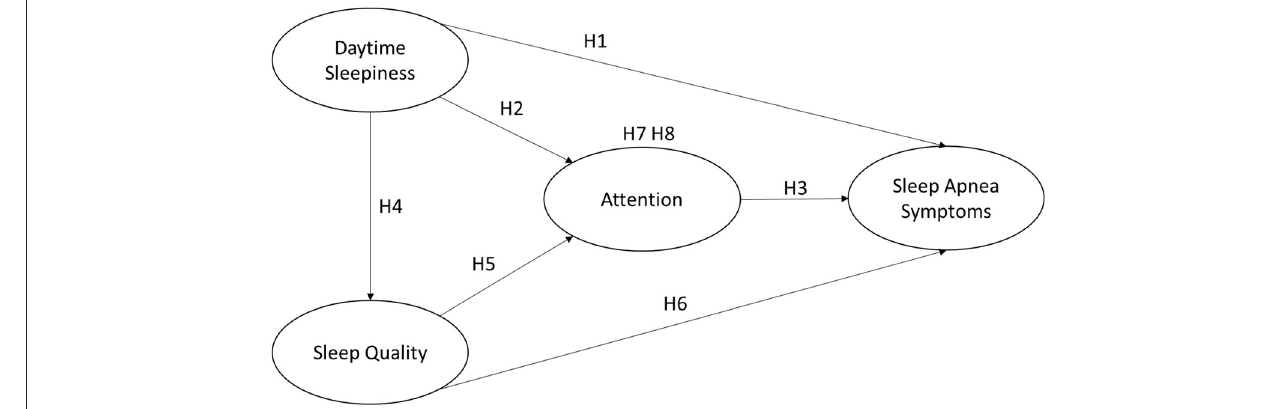
FIGURE 1 | Research framework.